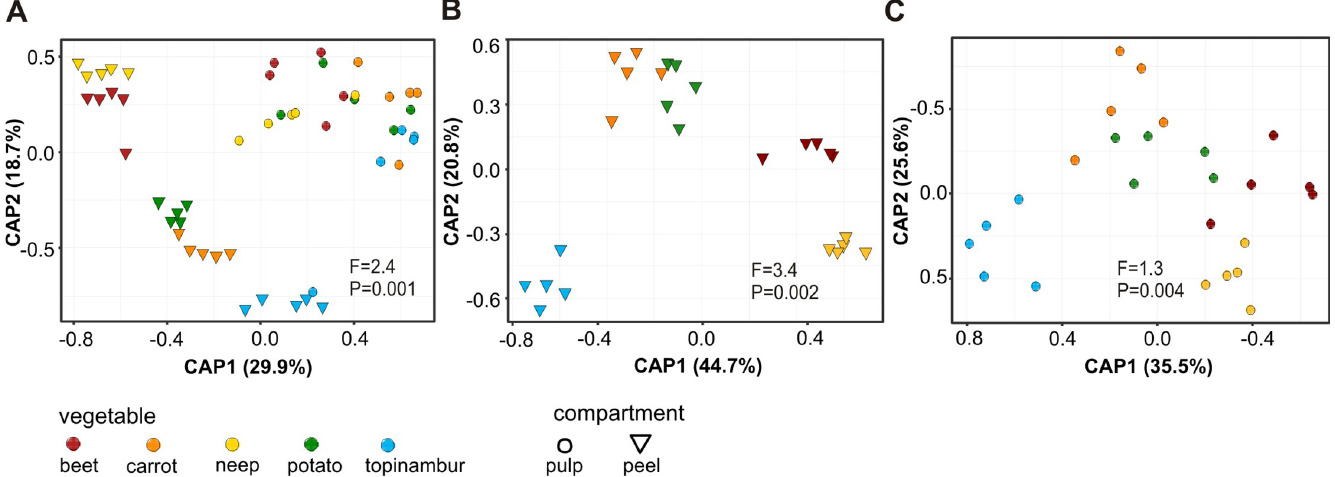
Fig 2. Bacterial community structure of five root vegetables. Bray–Curtis distances and Constrained Analysis of Principal Coordinates (CAP) of OTUs were performed for both vegetable compartments (peel/pulp) and each vegetable species. (A) CAP constrained by compartments and vegetable species. (B) CAP of vegetable peels constrained by vegetable species. (C) CAP of vegetable pulps constrained by vegetable species. Both the F-statistic and P-values are shown.